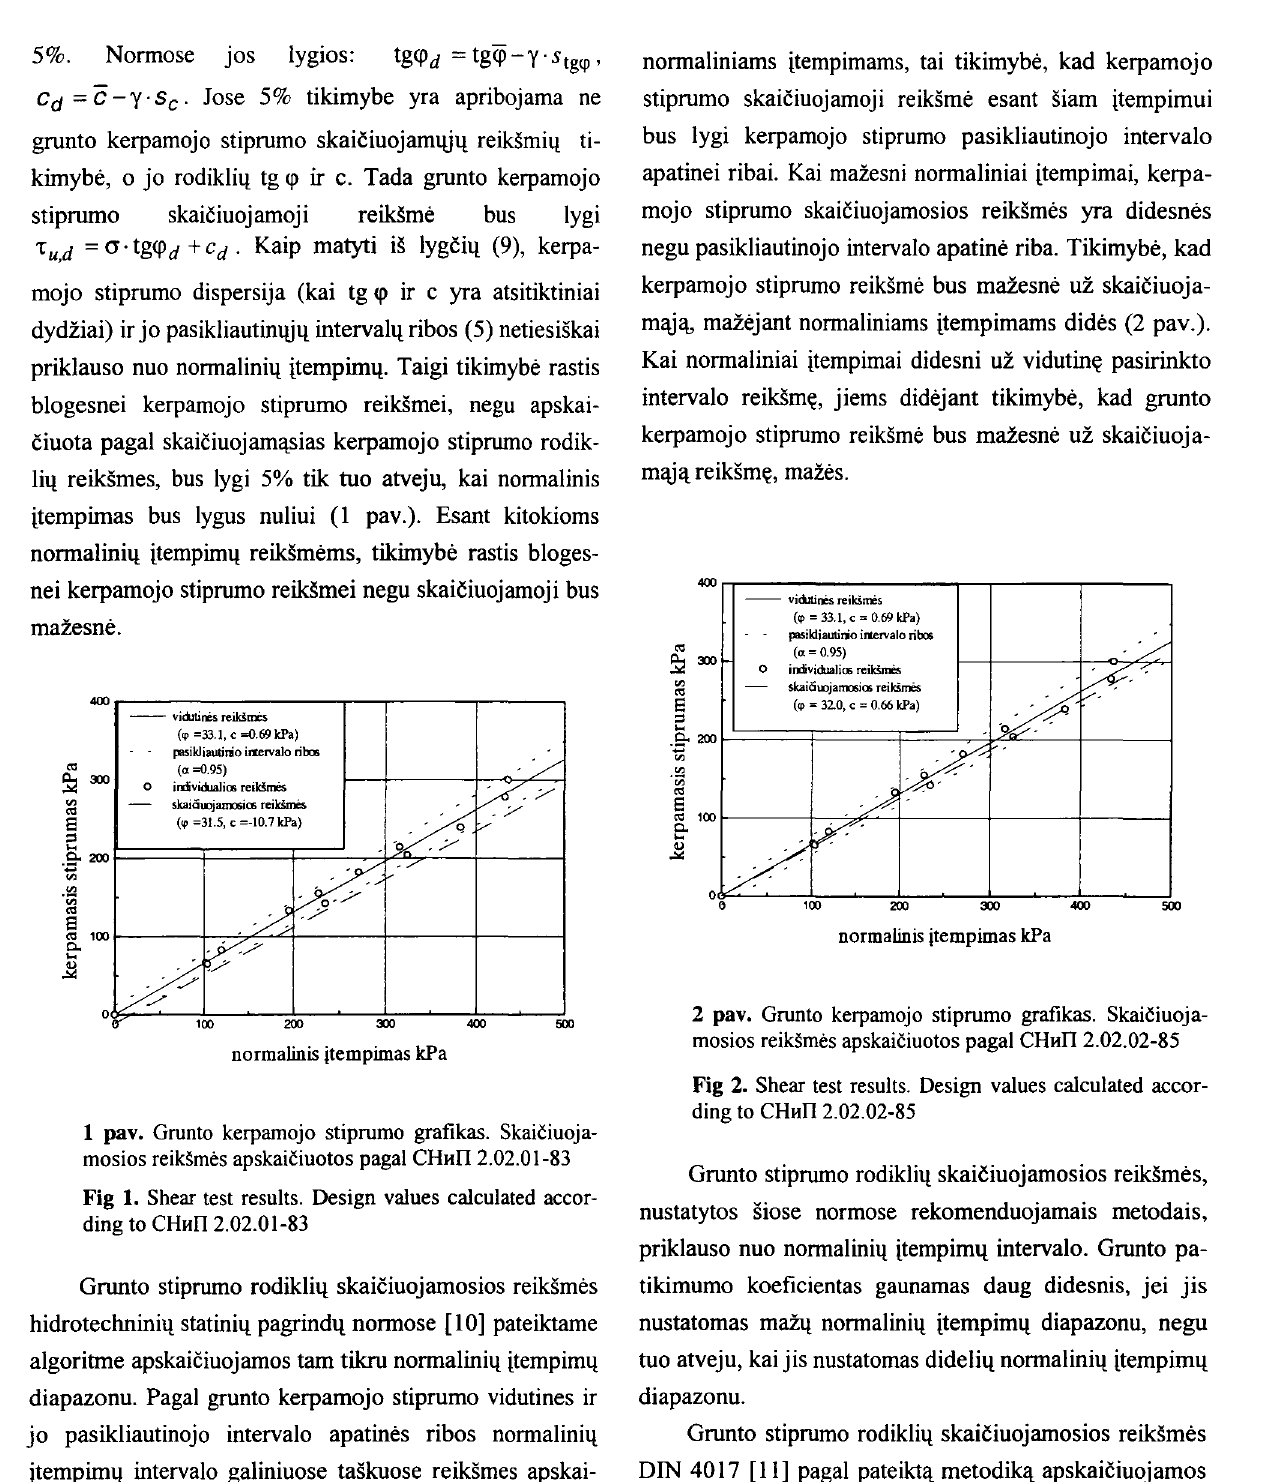
Fig 2. Shear test results. Design values calculated accor ding to CHHII